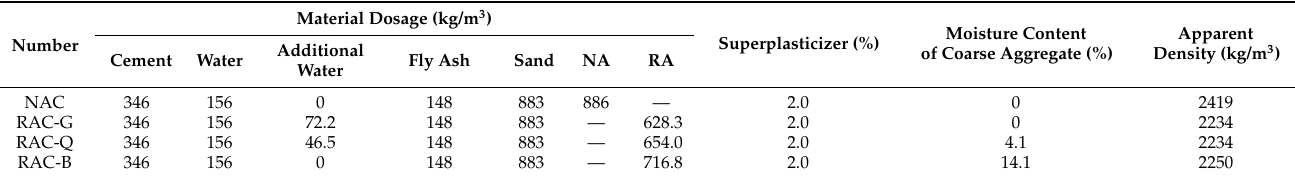
Table 4. Mix proportion of